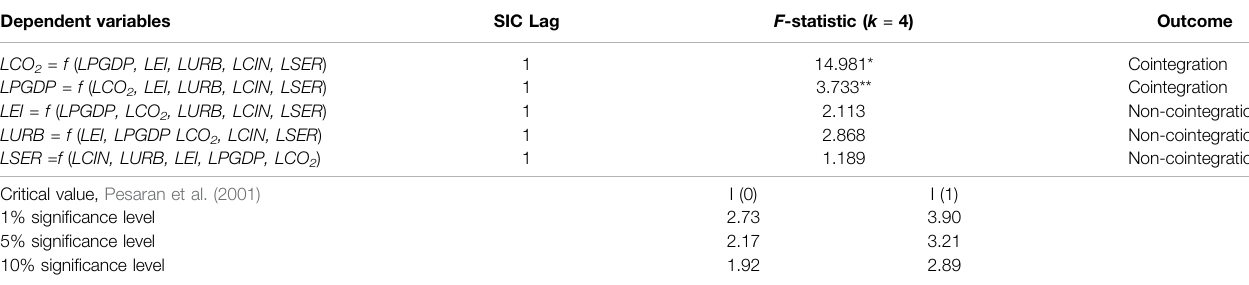
TABLE 4 | The estimated result for the ARDL bounds test (1,0,0,0,0). Dependent variables